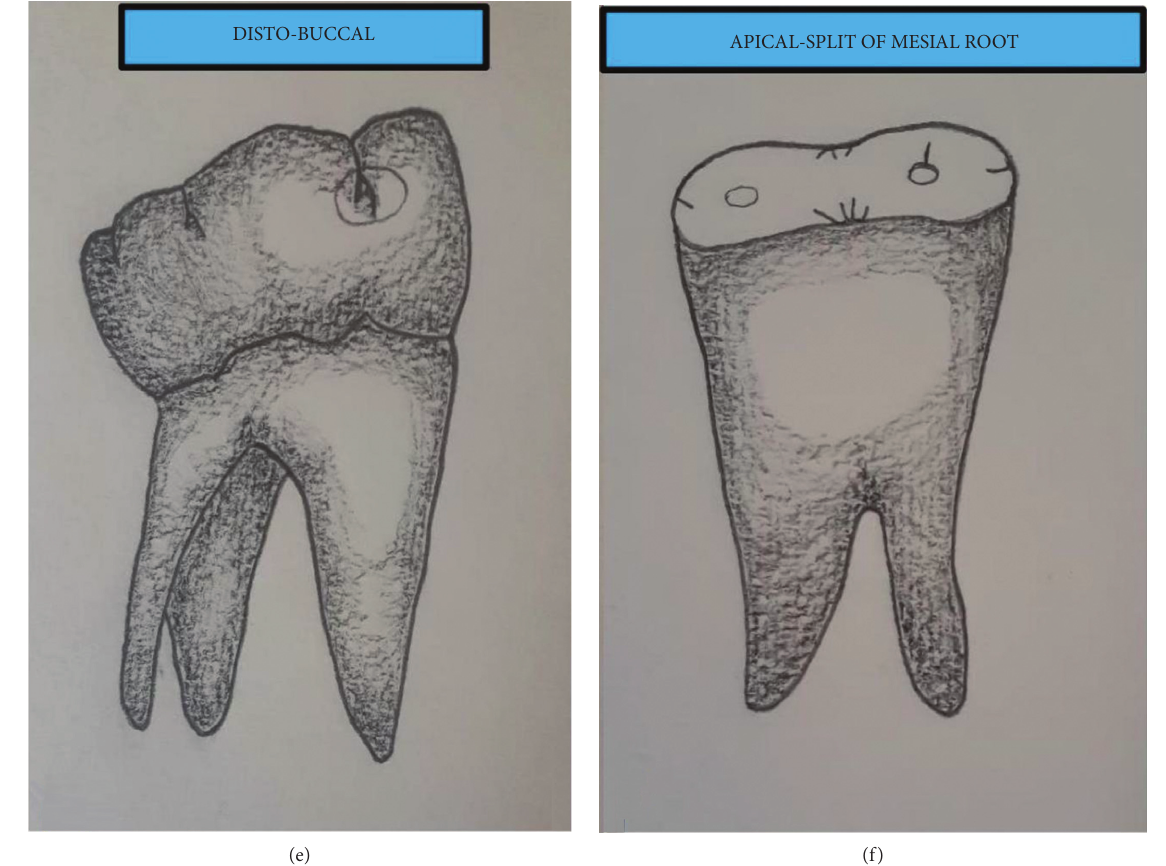
Figure 1: Variations in the position of the third root of right PMFM: (a) distolingual position at which the third root stands from the lingual aspect of the distal root, (b) centrolingual position at which the third root is midway between mesial and distal roots at the lingual surface, (c) mesial-lingual position at which the third root branches from and lingual to mesial root, (d) mesiobuccal position at which the third root stems from buccal aspect of mesial root, (e) distobuccal position at which the third root rises from buccal to distal root, and (f) the third root that splits from the apical third of the mesial